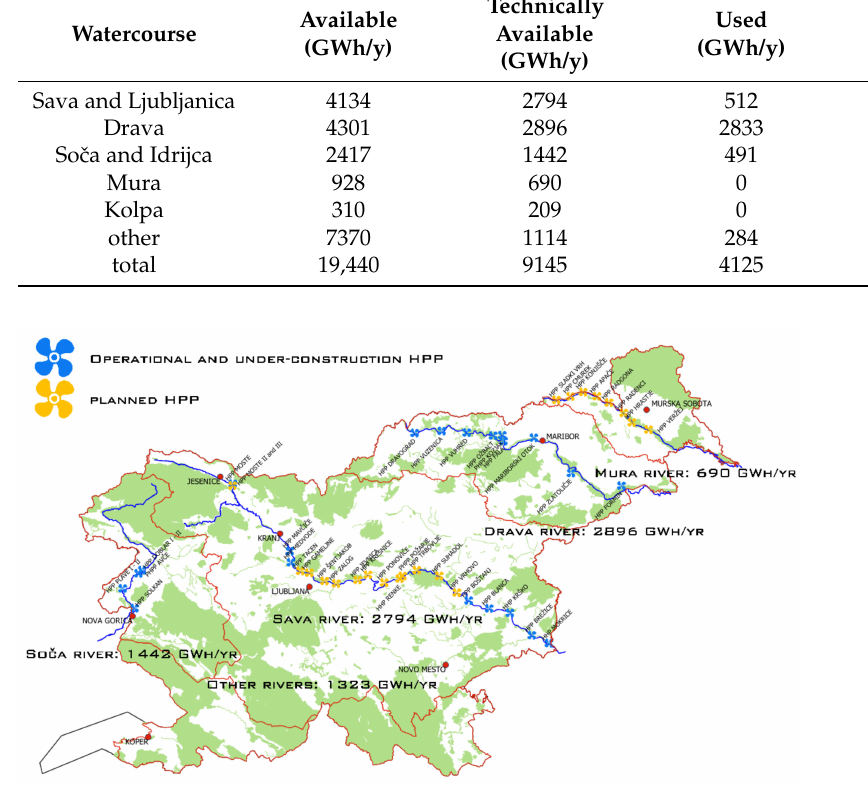
Figure 1. Large existing and planned hydropower plants in Slovenia and the energy potential of the main